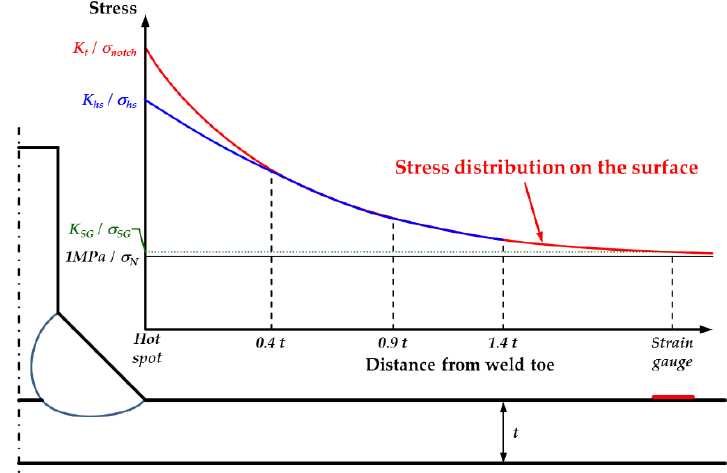
Figure 11. Definition of stresses and stress concentration factors.